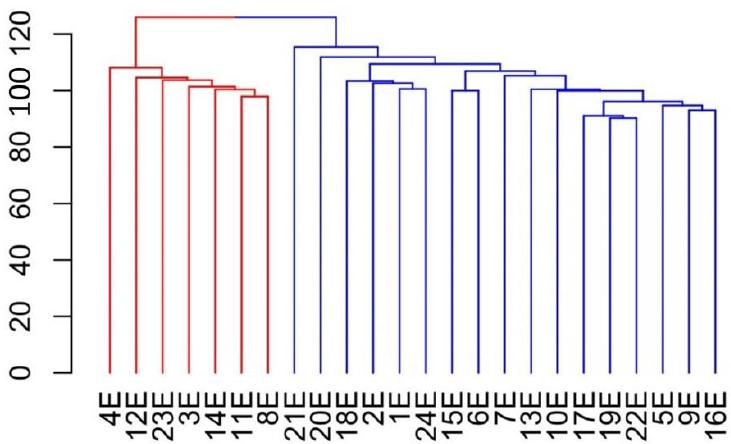
Figure 1. Hierarchically cluster analysis (HCA) based on Euclidean distances and average-linkage agglomeration method computed using a dataset of 15,959 SNP markers, adapted with permission from De Flaviis et al. [5]. Two Solina clusters are highlighted by red and blue colours.